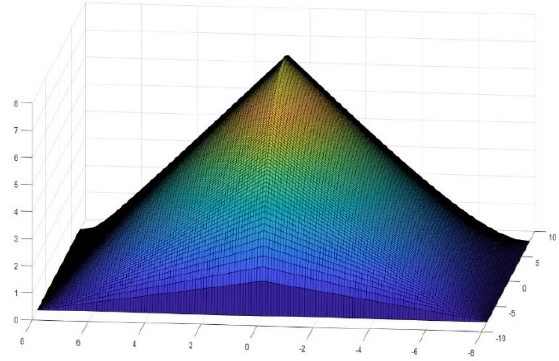
Figure 13. Detail of the upper part of the Antisphera.